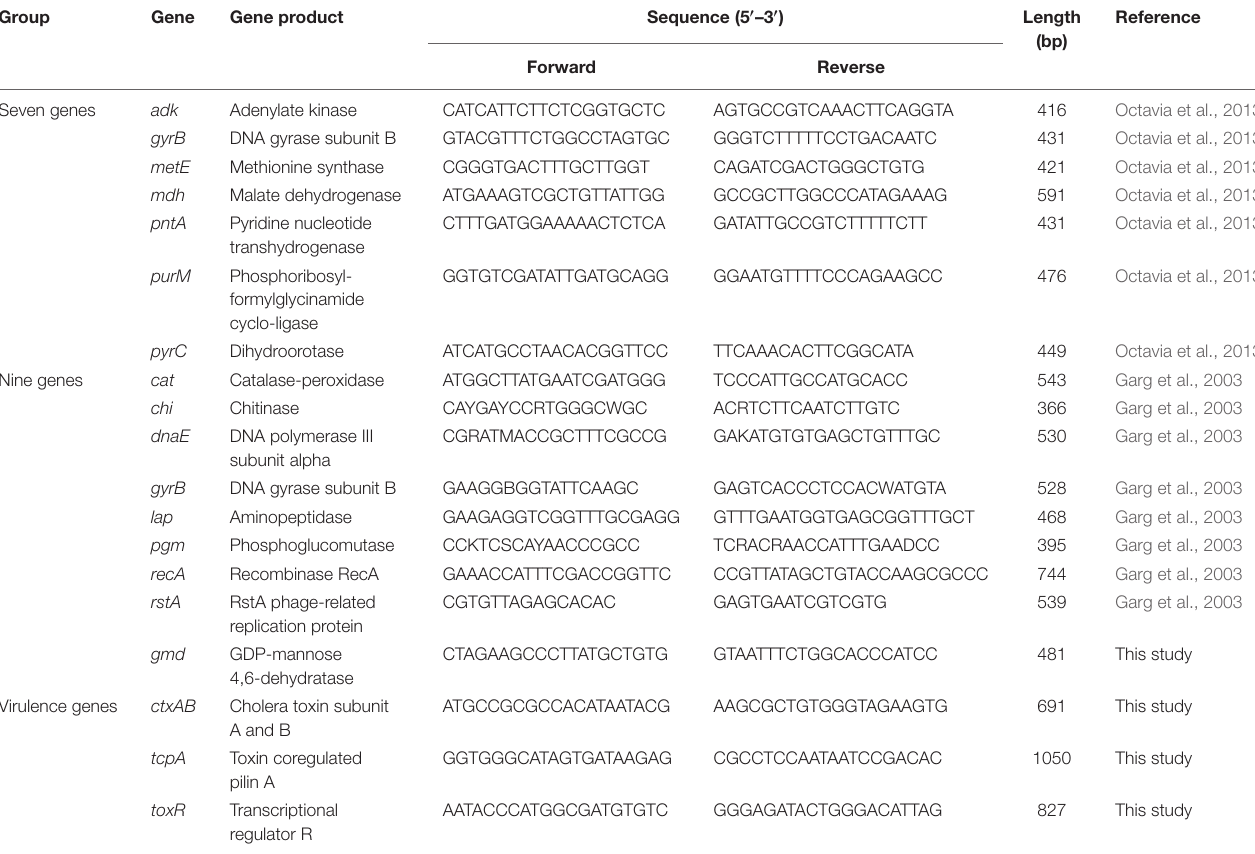
TABLE 2 | The primers used in this